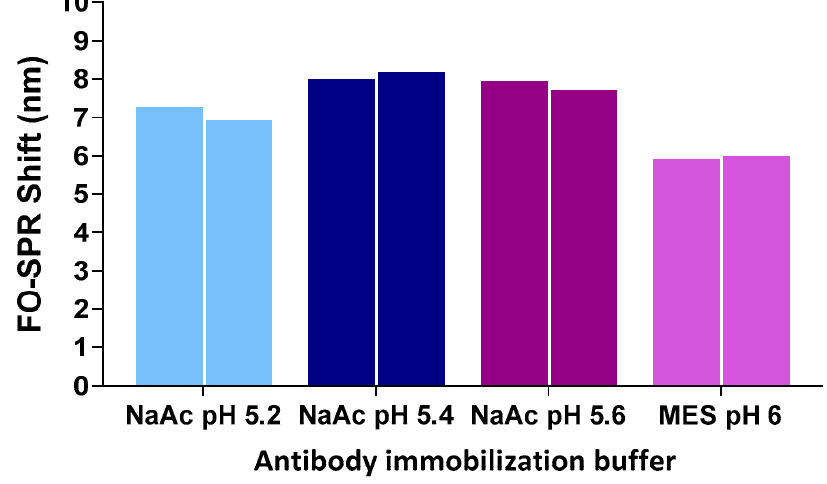
Figure 1. Bar graphs representing the FO-SPR shifts for the immobilization of anti-HER2 antibody using 4 immobilization buffers (10 mM NaAc buffer pH 5.2, 5.4, 5.6, and 50 mM MES buffer pH 6.0) obtained from two independent measurements.